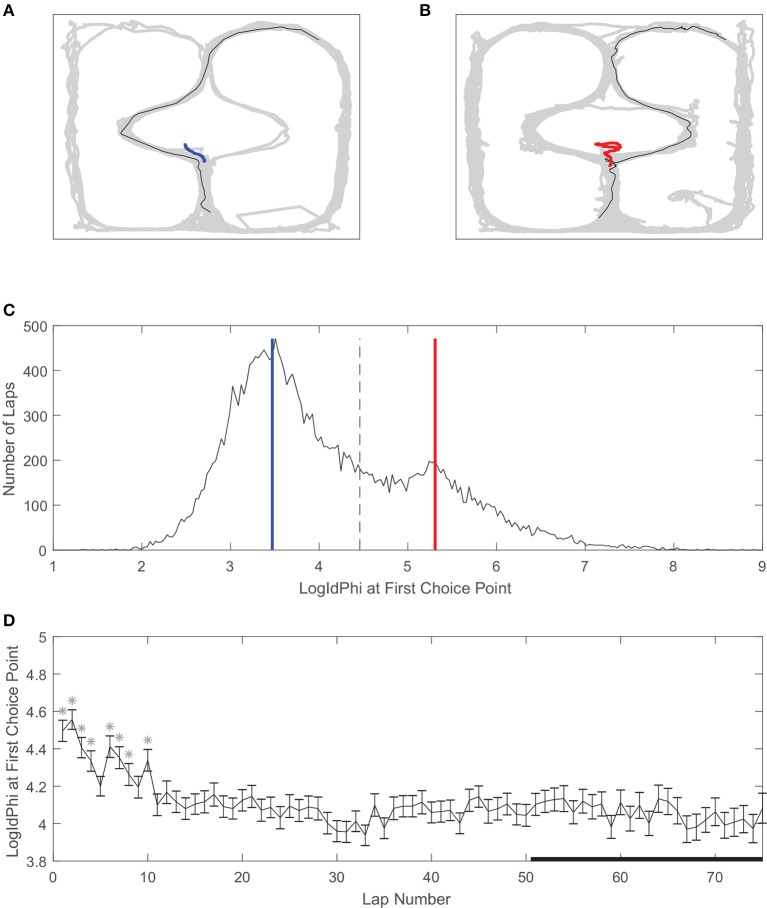
Vicarious trial and error (VTE) at the first choice point. (A) An example of a pass through the first choice point without VTE, and (B) an example of VTE at the first choice point. Gray line is rat body position over the whole session, black line is rat body position on example lap, and red or blue lines are rat head position at the first choice point on the example lap. (C) Distribution of LogIdPhi values at the first choice point over all laps, sessions, and rats. Blue line corresponds to LogIdPhi value at the first choice point in the example lap shown in A, and the red line to the example lap shown in B. Dashed line is the VTE/non-VTE threshold (see section Methods). (D) LogIdPhi over the course of a session. Error bars indicate SEM. Stars indicate laps for which LogIdPhi was significantly greater than that of laps 51 and greater. Data has been aggregated over rats (N = 357, the total number of sessions). Error bars show SEM.